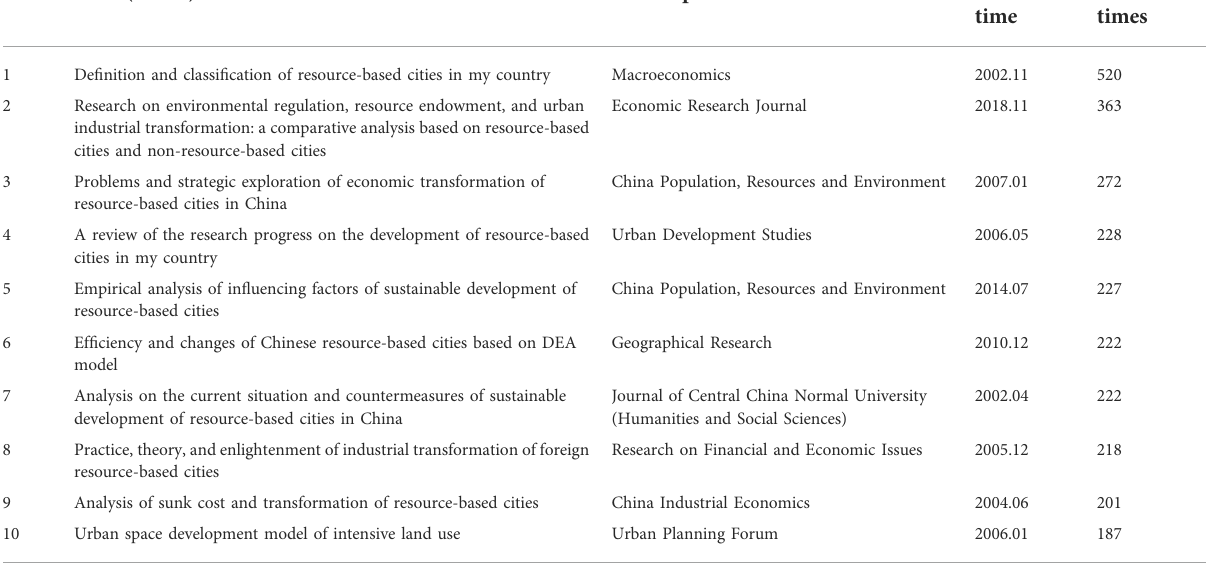
TABLE 3 Highly cited Chinese studies on resource-based cities (top